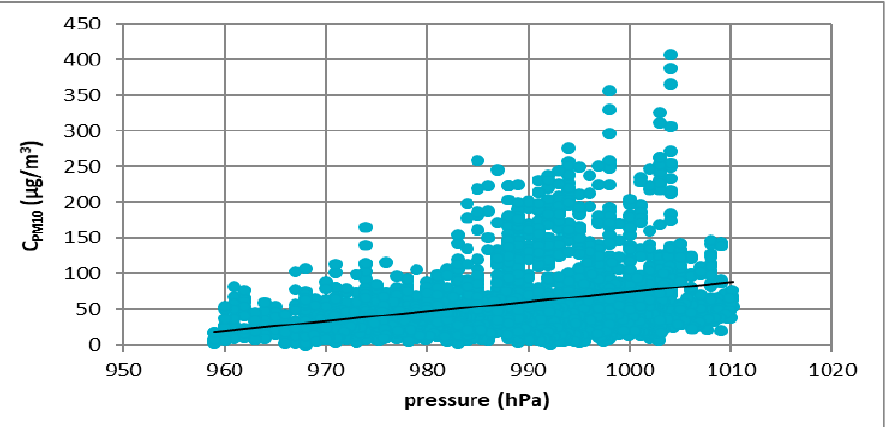
Figure 7. The effect of atmospheric pressure on PM10 concentration in Ł ód ź in 2017. Figure 7. The e ff ect of atmospheric pressure on PM10 concentration in Ł ó d´z in